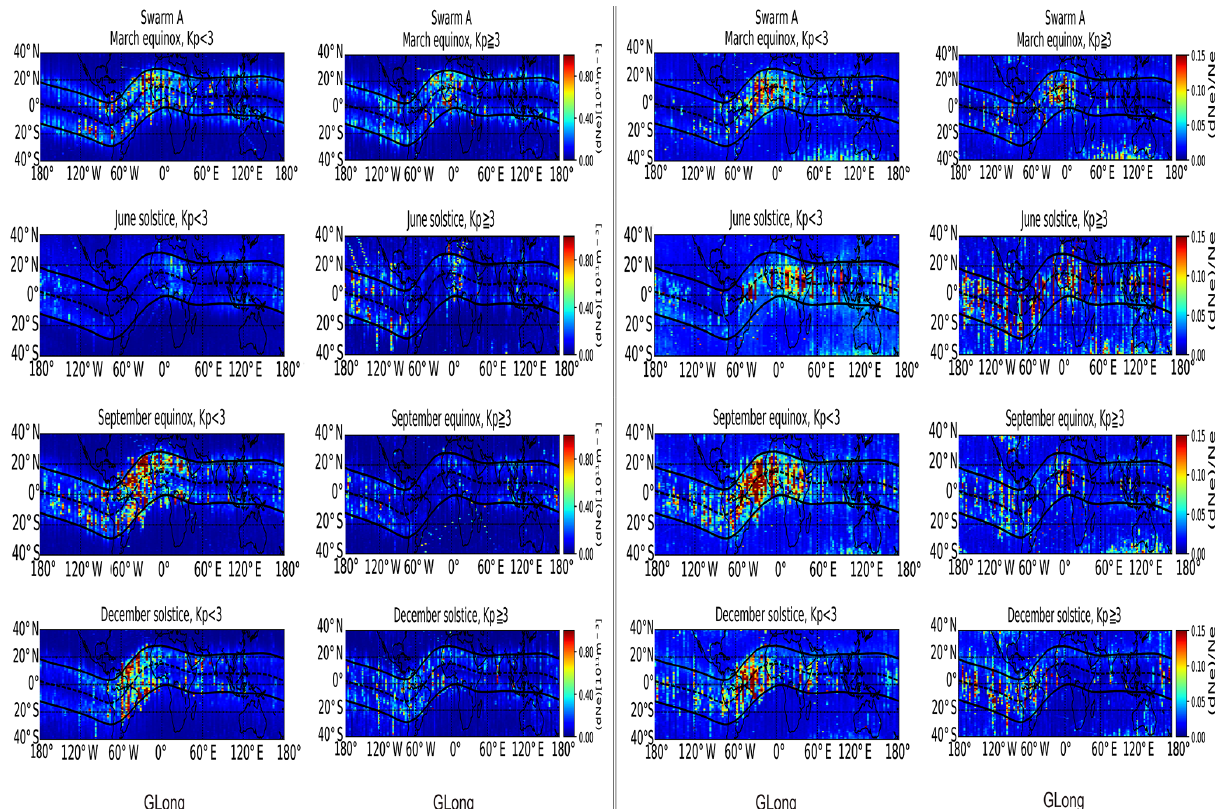
Figure 14. Geomagnetic effect on seasonal and longitudinal distribution of dN e and dN e /N e for the period from October 2014 to Octo- ber 2018: a case for Swarm